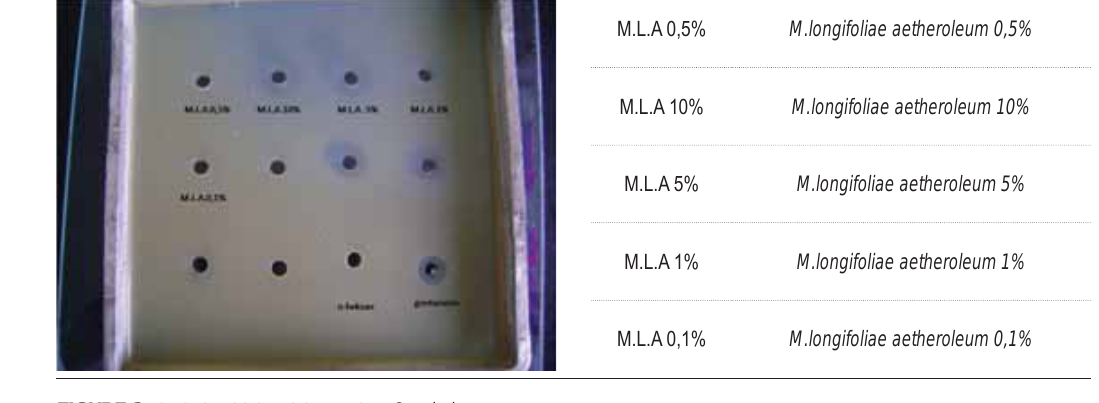
FIGURE 2. Antimicrobial activity against Staphylococcus aureus